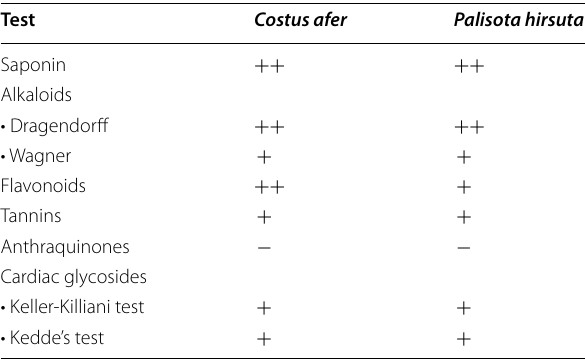
Table 4 Phytochemical screening result of Costus afer and Palisota hirsuta powdered leaf samples